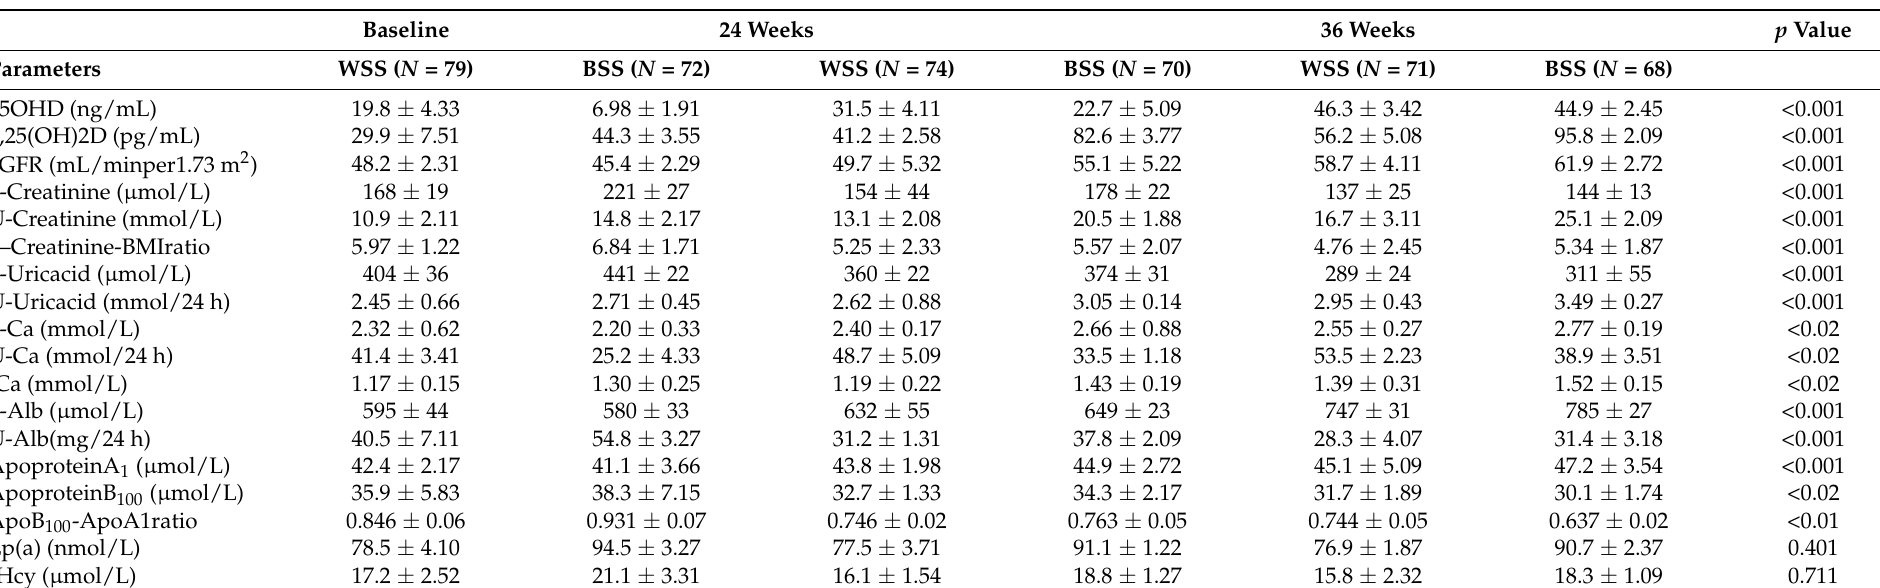
Table 5. Effects of oral 60,000 IU vitamin D3 supplementation/month at 24 and 36 weeks on serum vitamin D level, CKD clusters and thromboembolic biomarkers in Blacks versus Whites SS